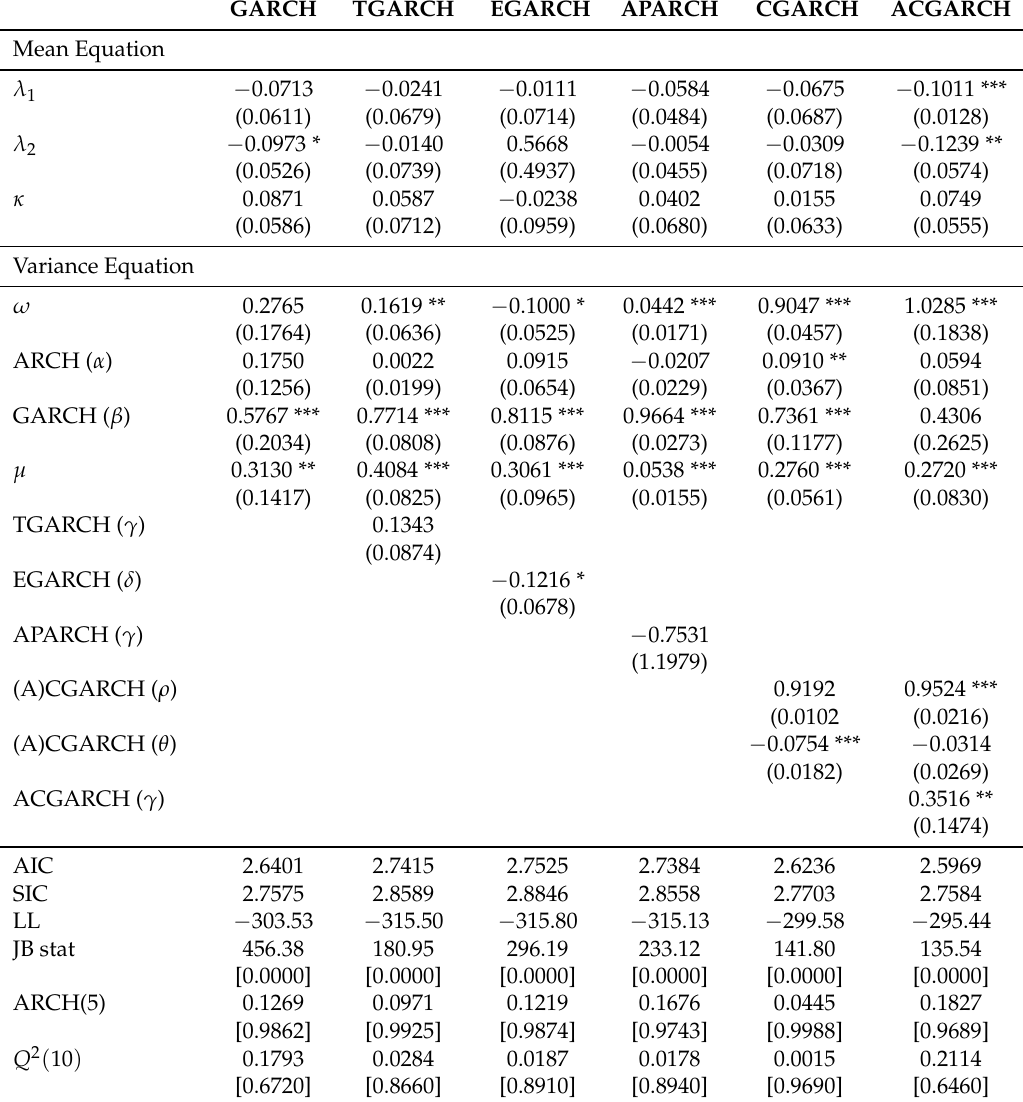
Table A14. GARCH-M Tests for Litecoin for the recovery